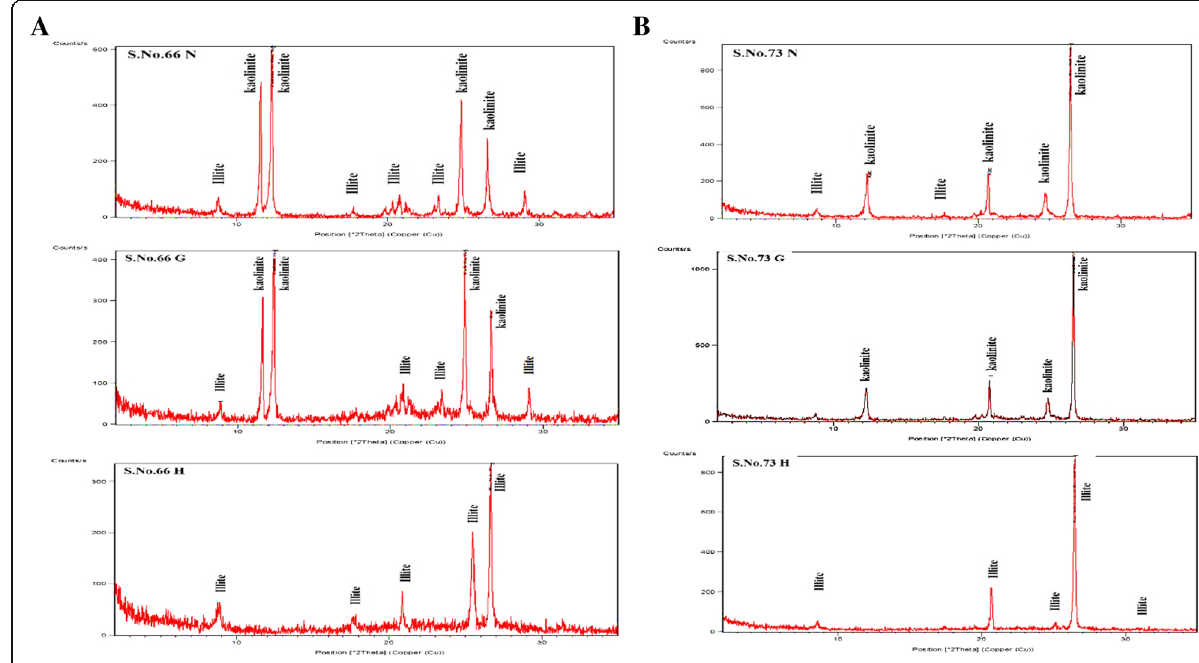
Fig. 4 X-ray diffraction pattern of oriented clay samples of Paleozoic mudrocks, a S. No. 66 and b S. No.